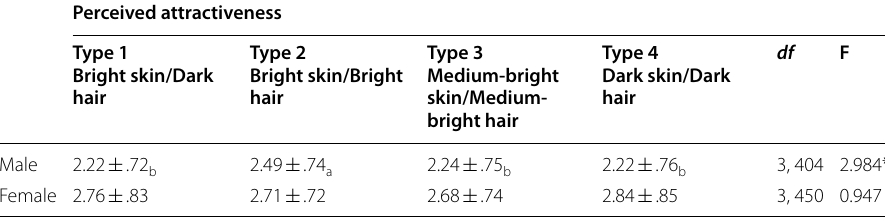
Table 2 The results of the T -test for perceived attractiveness